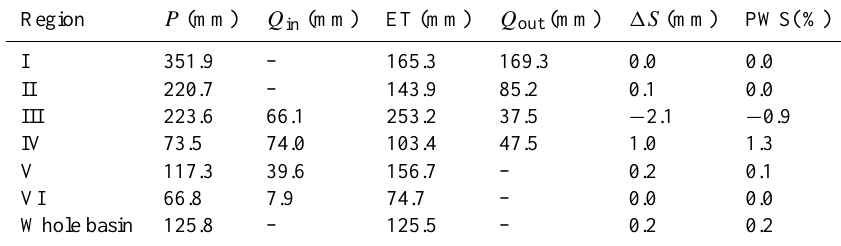
Table 2. The mean annual water balance of all regions.